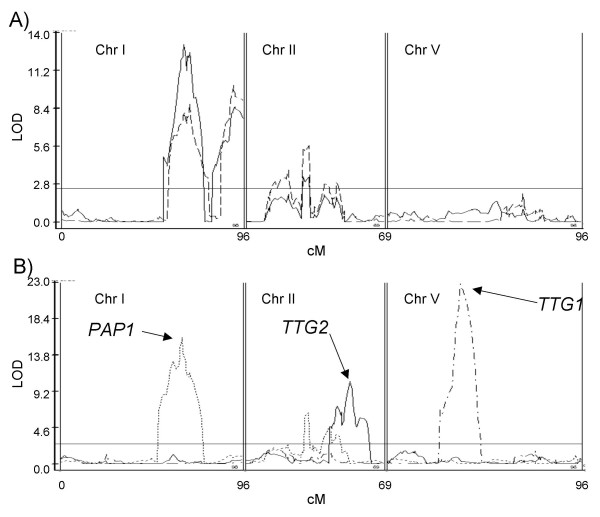
Flavonol (FV) biosynthetic gene expression network eQTLs versus transcription factor eQTLs. The vertical lines separate the genome into chromosomes I-V (as labeled at the top) with cM progressing left to right along the x axis and the length of each chromosome in cM at the end of each chromosome. Only chromosomes I, II and V were included in the figure since chromosomes III and IV did not contain eQTLs for any of the traits described. A) Network eQTLs controlling the expression of flavonol biosynthetic genes. The solid black line is the mean FV network expression utilizing the log2 normalized gene expression. The dashed black line is the mean network expression utilizing the z score gene expression. B) eQTLs controlling the expression of transcription factors known to regulate the flavonol biosynthetic gene expression. TTG1 (AT5G24520), TTG2 (AT2G37260) and PAP1 (AT1G56650) detected eQTLs, while TT2 (AT5G35550), TT16 (AT5G23260) and TT8 (AT4G09820) did not. The arrows show the genomic position of the TTG1, TTG2 and PAP1 genes.